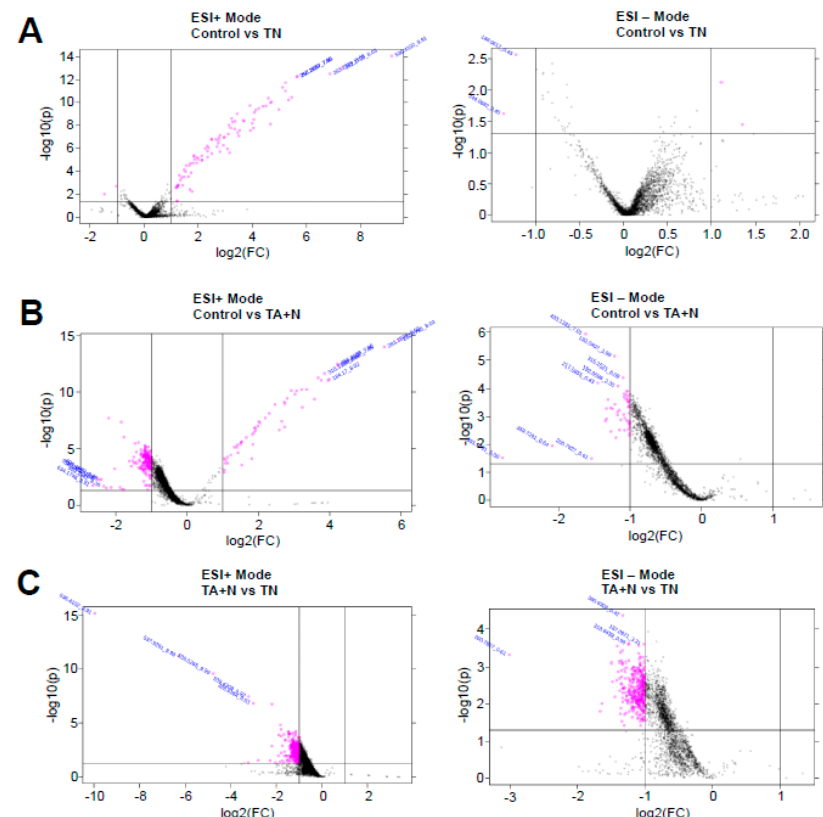
Figure 2. Volcano plots. ( A ) ESI + and − modes of control vs vitamin E nicotinate (TN); ( B ) ESI + and − modes of control vs. vitamin E acetate + niacin (TA + N); ( C ) ESI + and − modes of TN vs. TA + N. Human pulmonary artery smooth muscle cells were treated with either TN (100 µ M) or with TA (100 µ M) plus niacin (100 µ M) (TA + N) for 10 min. Samples were subjected to metabolomics analysis ( n = 9). The dot plots represent fold changes (FC) on the x-axis and statistical significance is shown by the p -value (p) on the y-axis. Pink dots represent values with p ≤ 0.05 and a multiplicative change of greater than two-fold.